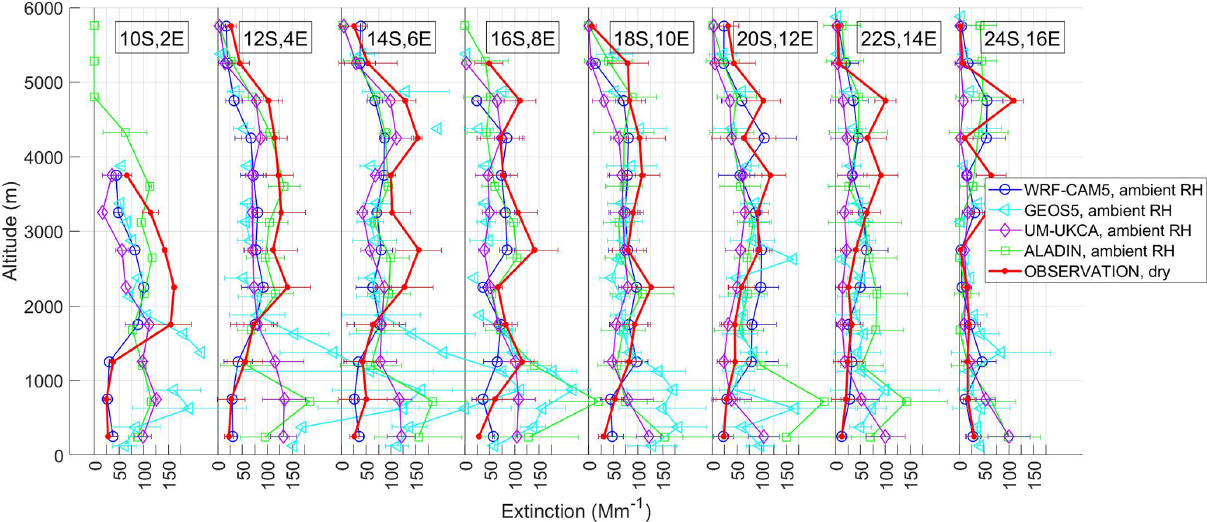
Figure 19. Vertical distribution of mid-visible ambient aerosol extinction from four models compared to dry ORACLES observations in 2 × 2 ◦ grid boxes (locations indicated) along the 2016 routine flight track.